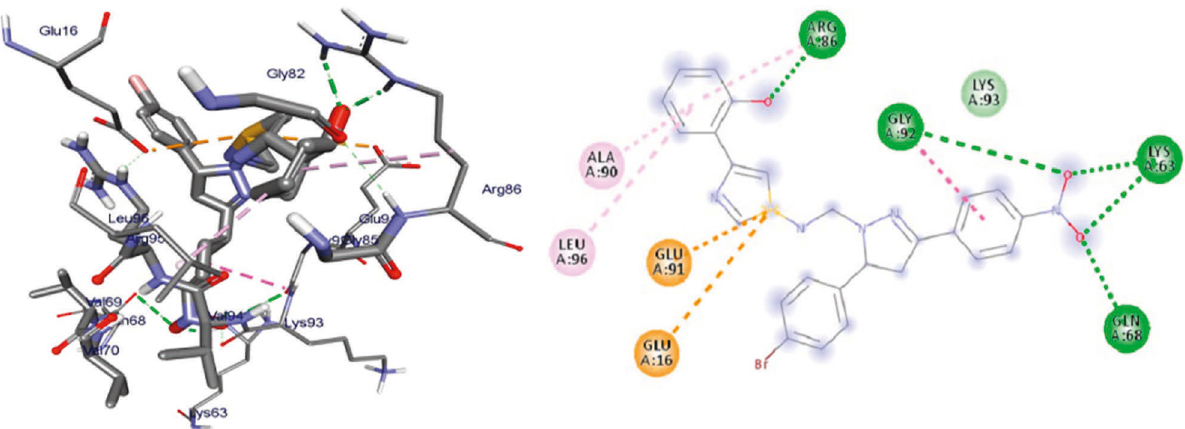
Figure 9: 3D (a) and 2D (b) representations of the binding interactions of 21 against human peroxiredoxin 5.